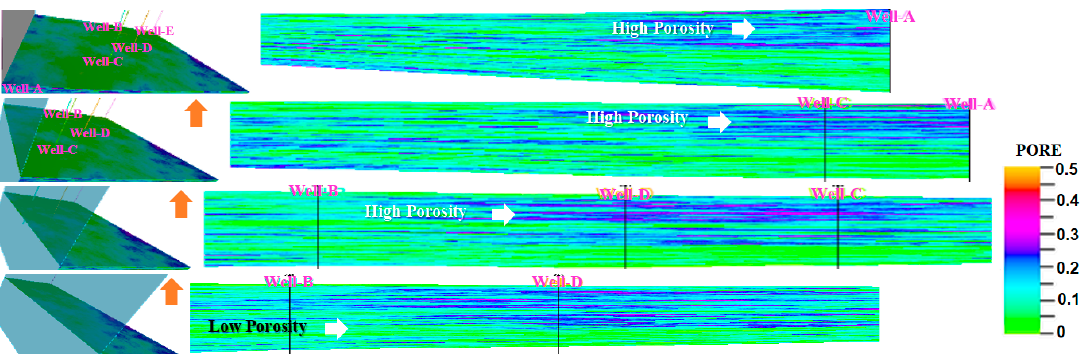
Figure 17. The cross-sectional analysis of 3D effective porosity model by well log simulation of C-sand interval.